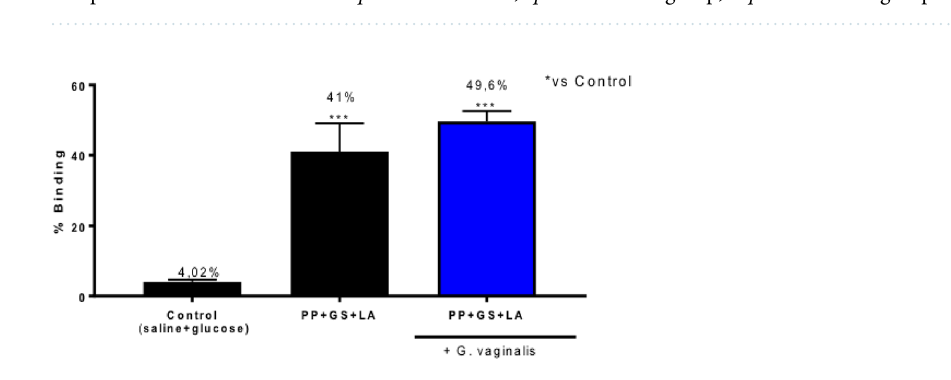
Figure 6. Mucoadhesive effect of the product containing PP, GS, and LA. The treatment with the product containing PP, GS and LA showed a significant binding percentage, respectively to respectively to 41% in absence of G. vaginalis infection and 49.6% in presence of G. vaginalis infection compared to control group (saline + glucose). *** p < 0.001 vs control